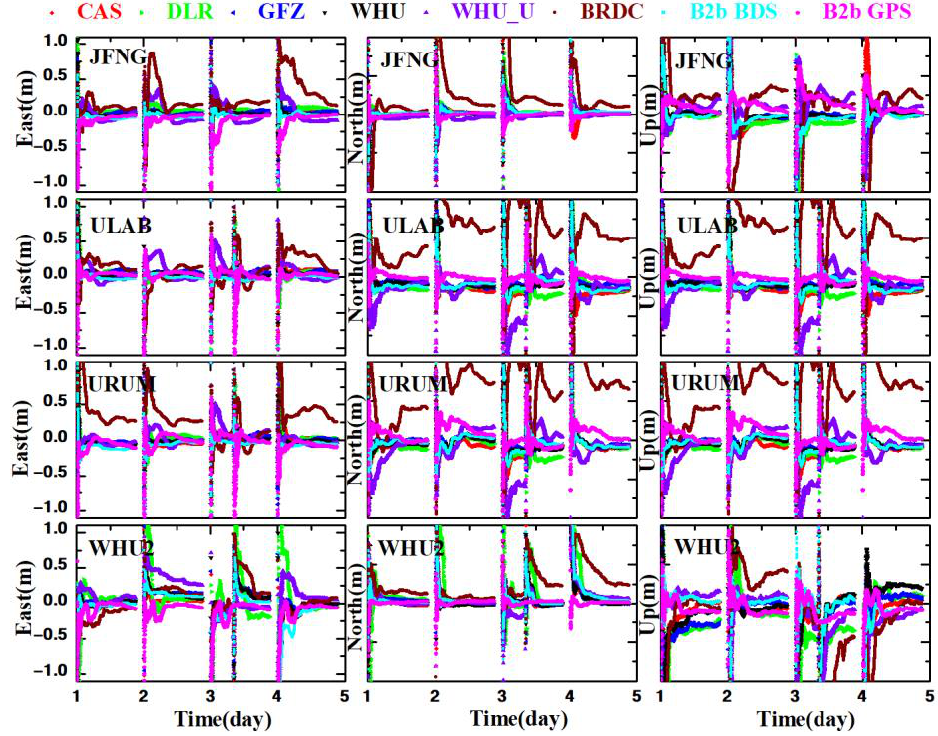
Figure 9. Time series of position errors of the four-day single-frequency static PPP.